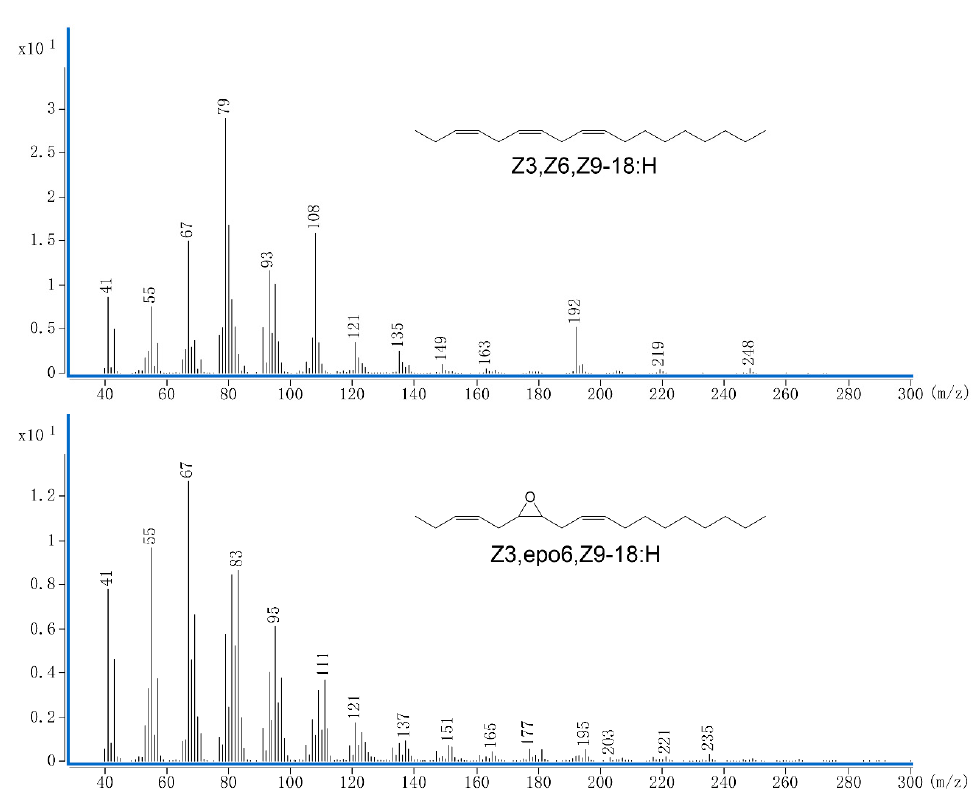
Figure 1. Mass spectrum and chemical structure of two sex pheromone compounds of Ectropis